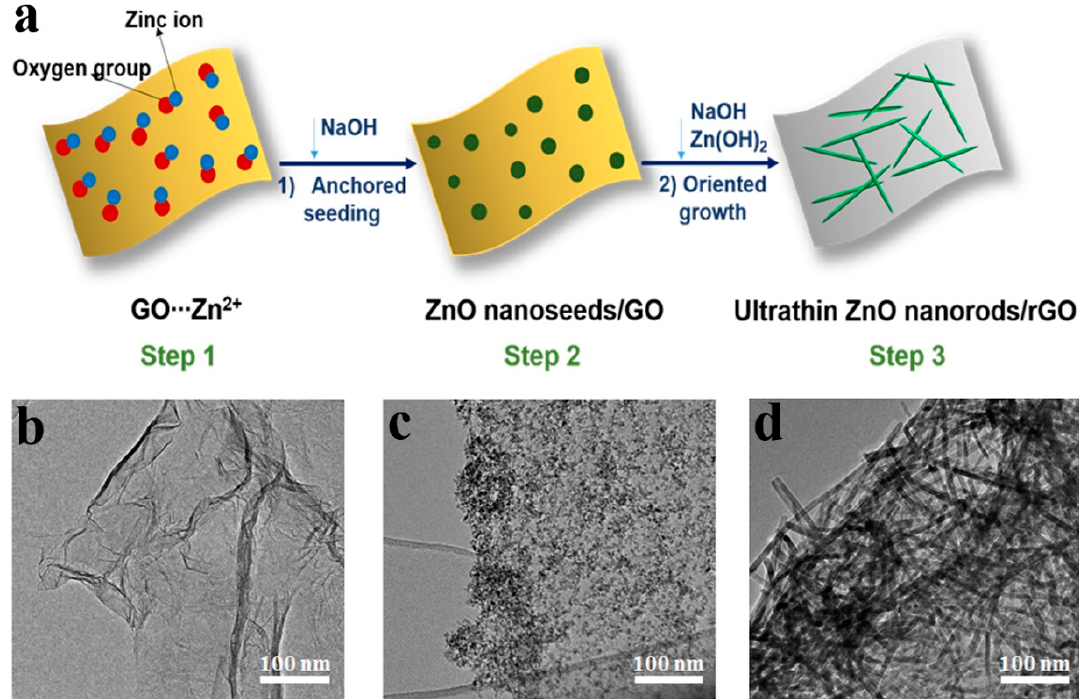
Figure 4. ( a ) Schematic illustration of fabrication of rGO/UT-ZNR; ( b–d ) TEM images of GO, GO/ZnO